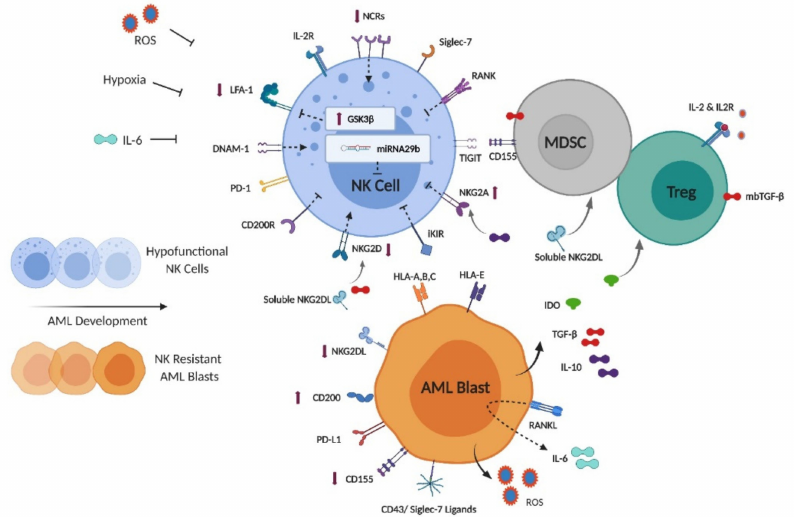
Figure 2. NK cell, blast cell and soluble factors in NK cell-AML immunoediting. ROS = reactive oxygen species; NCR = natural cytotoxicity receptor; LFA-1 = lymphocyte function-associated antigen 1; RANK = receptor activator of nuclear factor kappa-B; TIGIT = T-cell immunoglobulin and immunoreceptor tyrosine-based inhibitory motif (ITIM) domain; DNAM-1 = DNAX accessory molecule-1; PD-1 = programmed cell death protein 1; iKIR = inhibitory killer immunoglobulin receptor; MDSC = myeloid derived suppressor cell; Treg = regulatory T-cell; mbTGF- β = membrane bound transforming growth factor beta; PD-L1 = programmed death-ligand 1; IDO = indoleamine 2,3-dioxygenase; GSK3 β = Glycogen synthase kinase-3 β . Additional processes have been identified which suppress NK cell function in